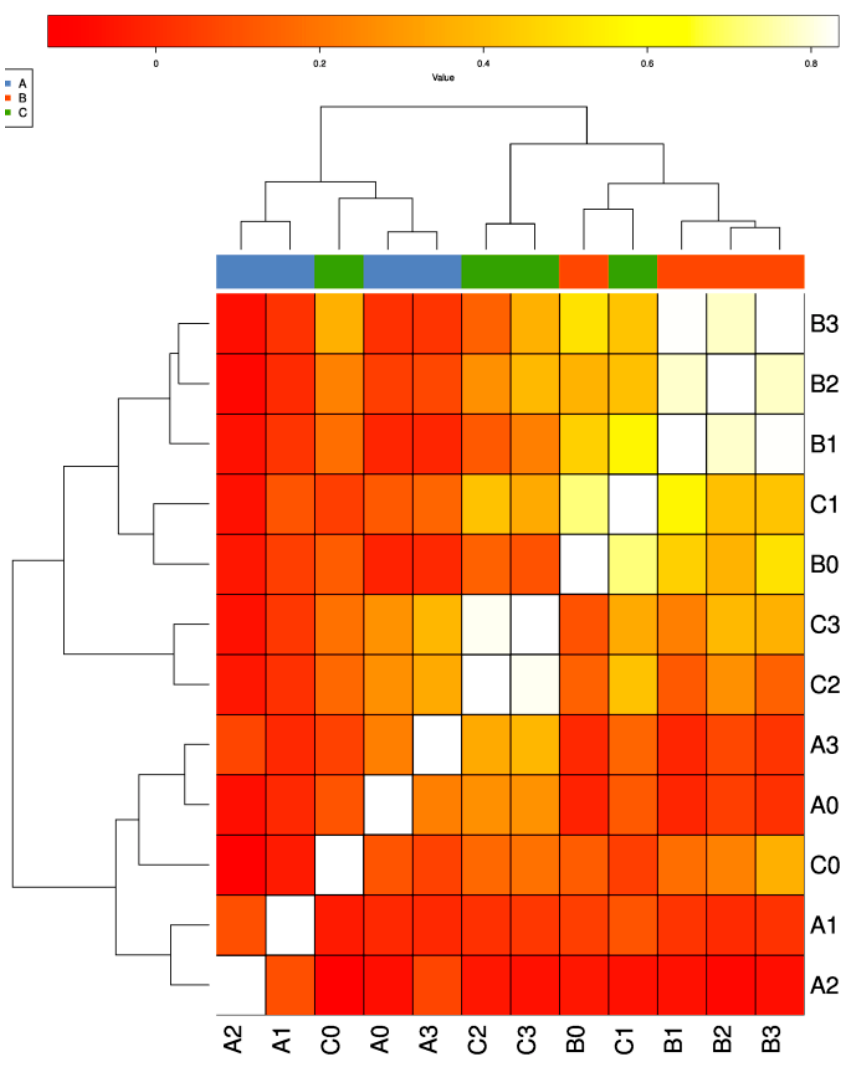
Figure 2. Correlation of ARGs between different samples: detected correlation of ARGs between different samples from the gut of C. semilaevis (A0–A3), water samples (B0–B3) and soil samples (C0–C3) to evaluate the possibility of HGT between the different biomes.